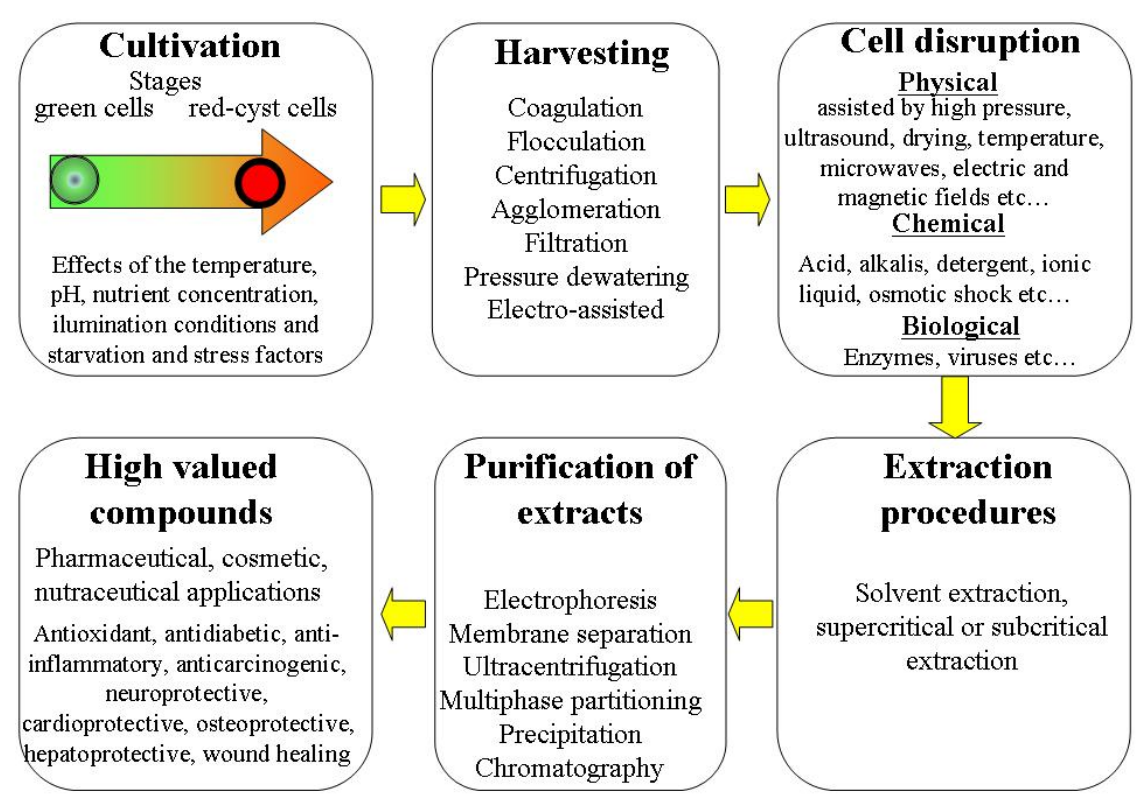
Figure 1. Overview of different steps in H. pluvialis microalgae processing biorefinery.